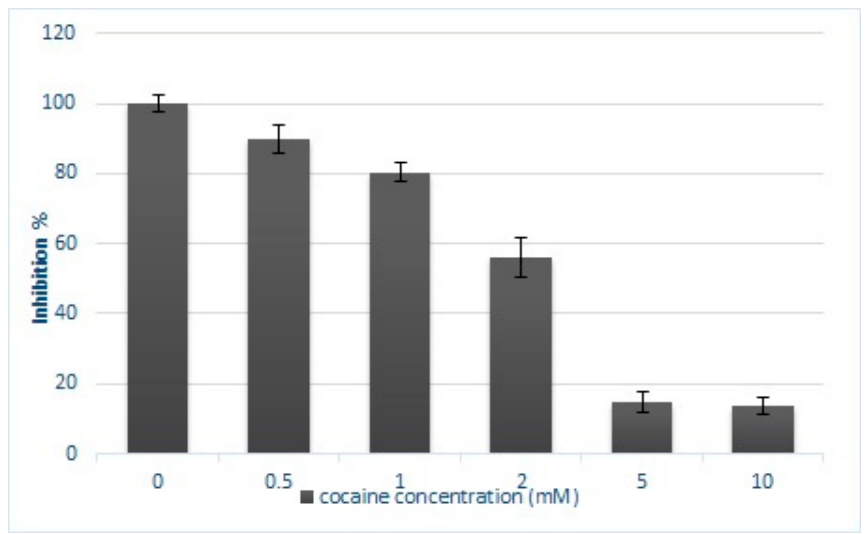
Figure 1. Cell inhibition of HepG2 cells exposed for 24 h to different concentrations (0.5, 1, 2, 5, and 10 mM) of cocaine. Data are expressed as a percentage of the control value and the values are presented as means ± SD of three independent experiments, each made in triplicate.